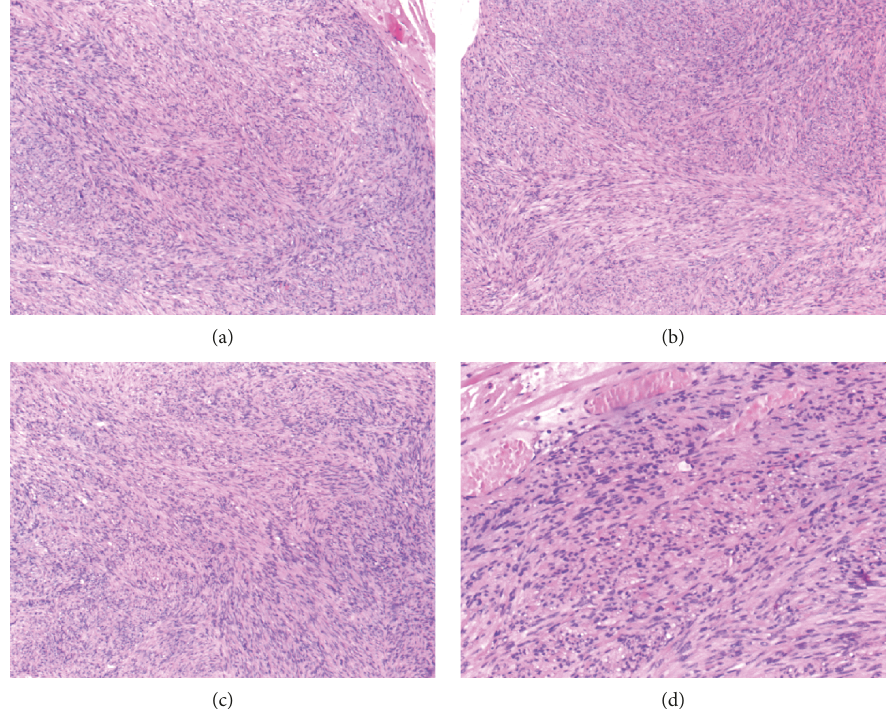
Figure 2: Histological fi ndings of the case of angioleiomyoma reported. (a, b, c) The tumor is well circumscribed and shows an admixture of bundles of smooth muscle cells surrounding the blood vessels (4x); (d) AL: high-power view